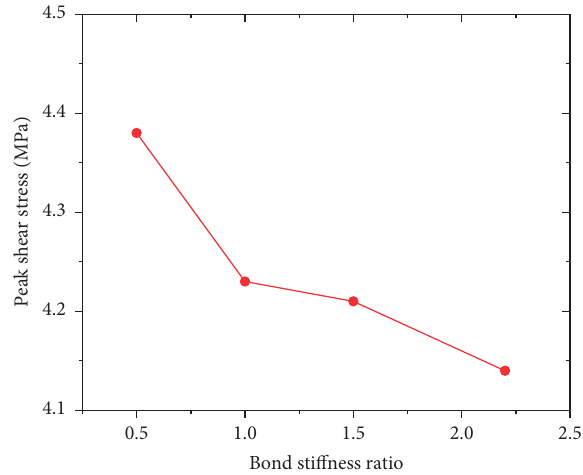
Figure 9: Relationship between bond stiffness ratio and peak shear stress.